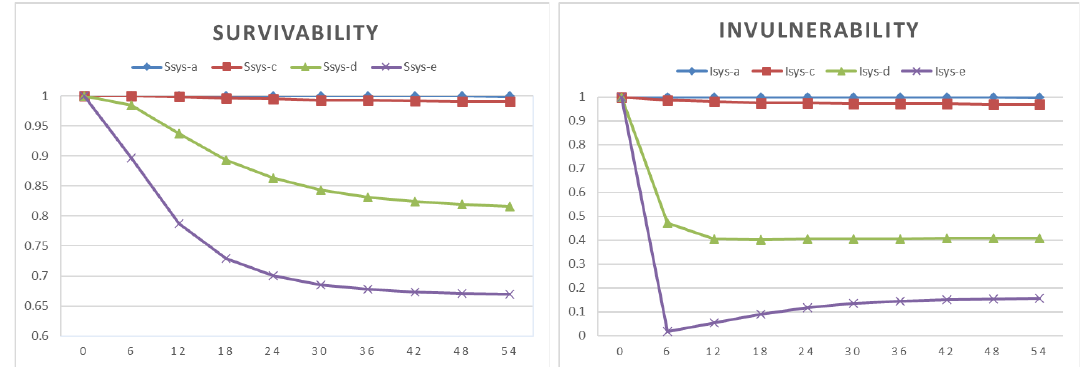
Figure 9. System survivability and invulnerability under different ρ gv ( x -axis: mission